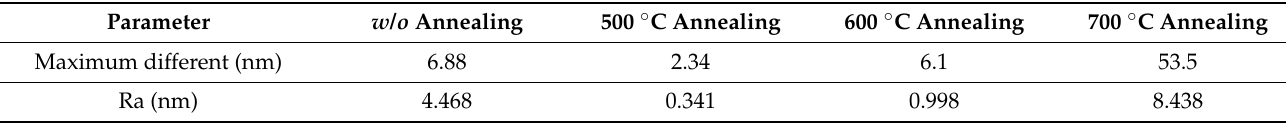
Table 1. The results of atomic force